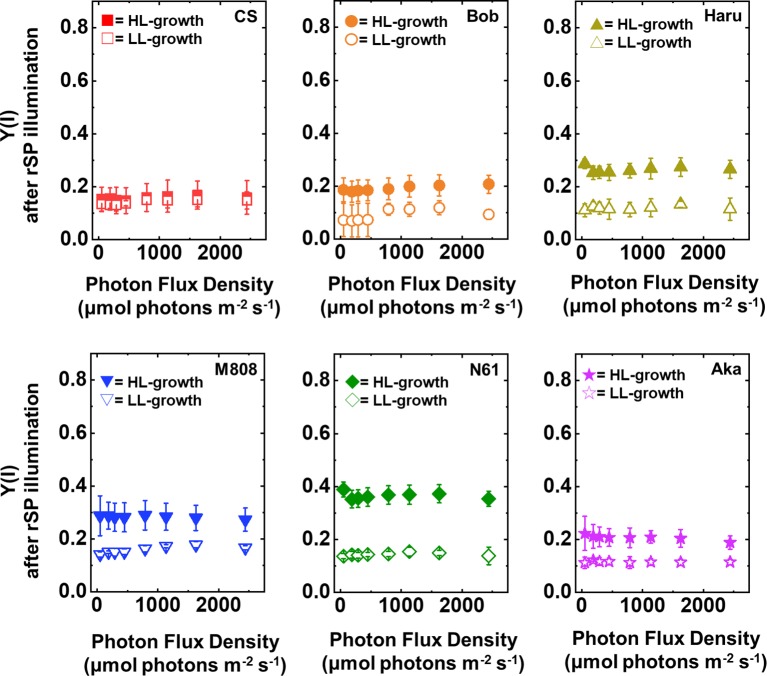
The response of Y(I) to light intensity in six wheat cultivars grown under LL (open symbol) and HL (closed symbol) conditions after rSP illumination for 1 h. The measurement was conducted under atmospheric conditions (21 kPa O2, 40 Pa CO2) at 25°C. Data are expressed as mean ± SD of three to four independent experiments. Red squares indicate the results of CS, orange circles indicate the results of Bob, dark yellow triangles indicate the results of Haru, blue inverted-triangles indicate the results of M808, green diamonds indicate the results of N61, and purple stars indicate the results of Aka.